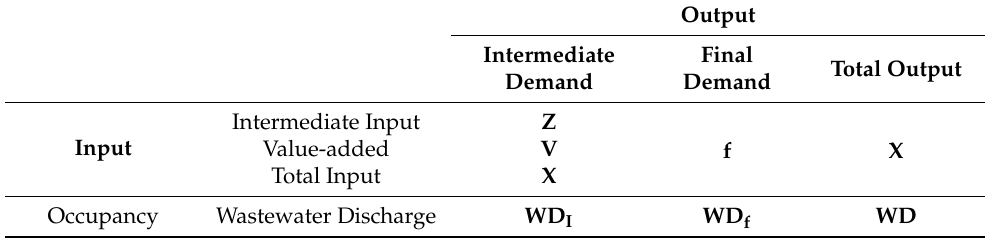
Table A1. China’s input-occupancy-output tables format for 2002, 2007, 2012, and 2017 in Zheng [25].